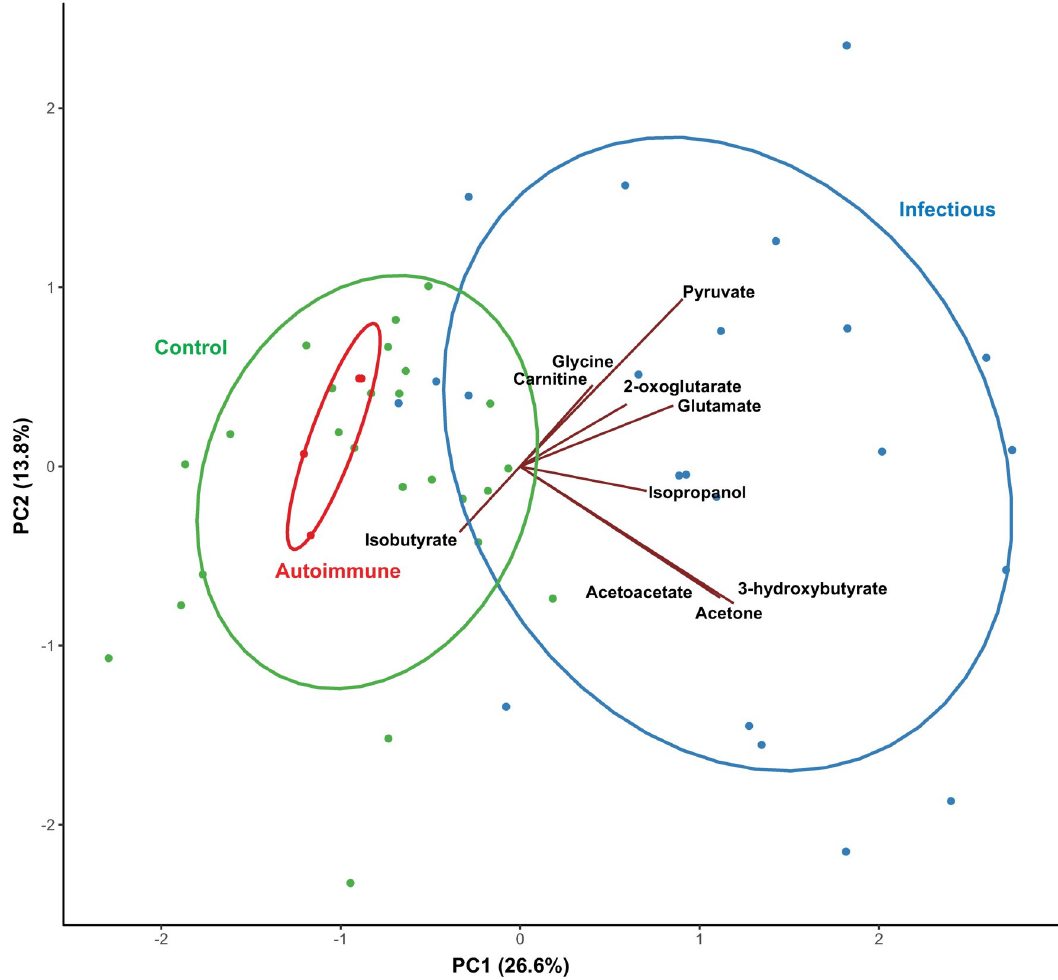
Fig 1. Principal component analysis of 1 H-NMR CSF metabolomic data comparing infectious or autoimmune disease or controls. Axes represent principal component (PC) scores. The percent of the variation explained by each component is given in parentheses. Green circles represent control patient samples, red circles represent multiple sclerosis patient samples, and blue circles represent infectious disease patient samples. Normal data ellipses are shown for each group. Vectors represent loadings of select metabolites with PC1 and PC2, as drawn in the Gabriel’s biplot. Groups of vectors that point in similar directions tend to change together. One extreme observation was excluded to better visualize the data.